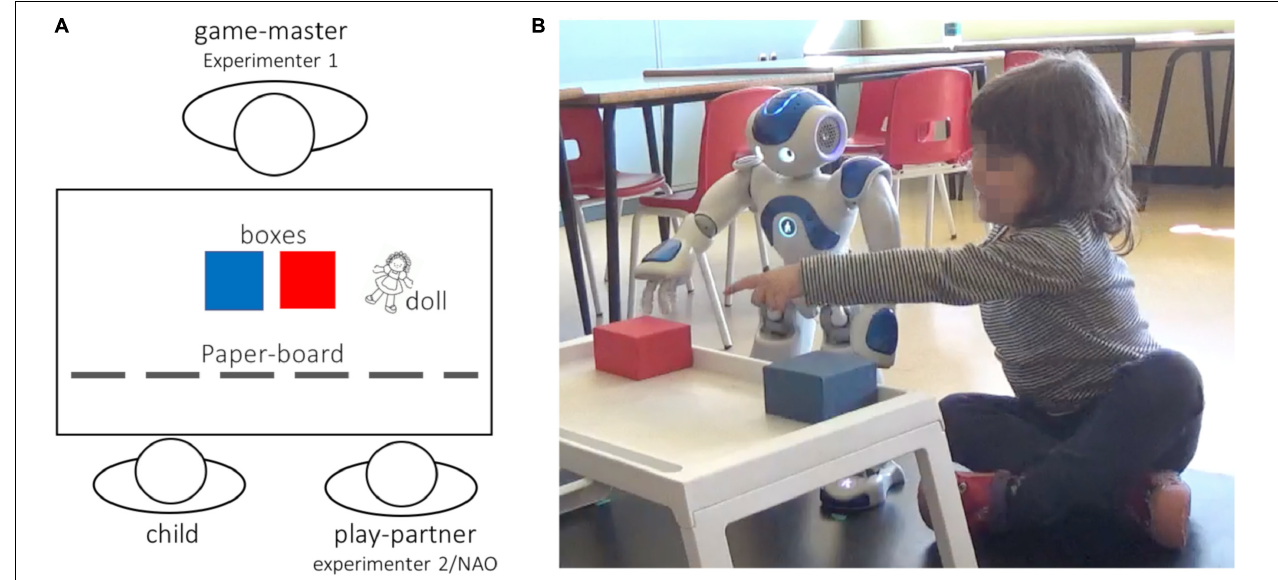
FIGURE 1 | Overview of the experimental setup in the Trust Game. (A) Overview of the participants’ seating arrangement and stimuli. (B) Photograph representing the SoftBank Robotics NAO humanoid robot while playing the Trust Game with a child (subject).